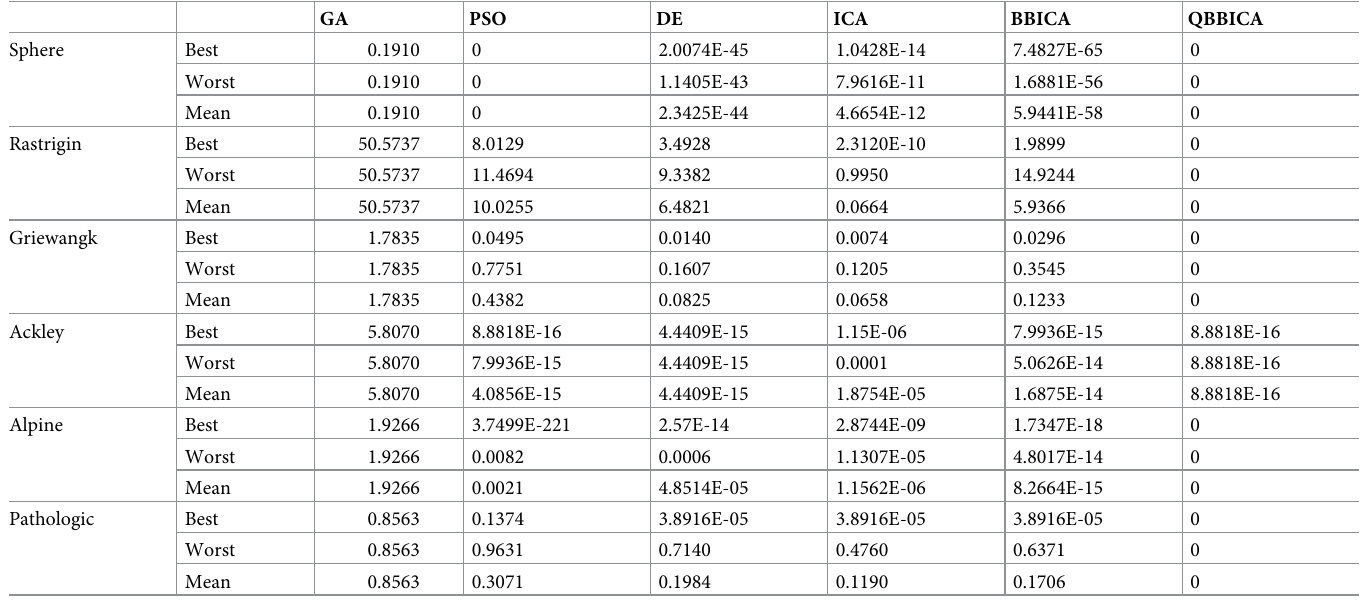
Table 2. Results of benchmark function